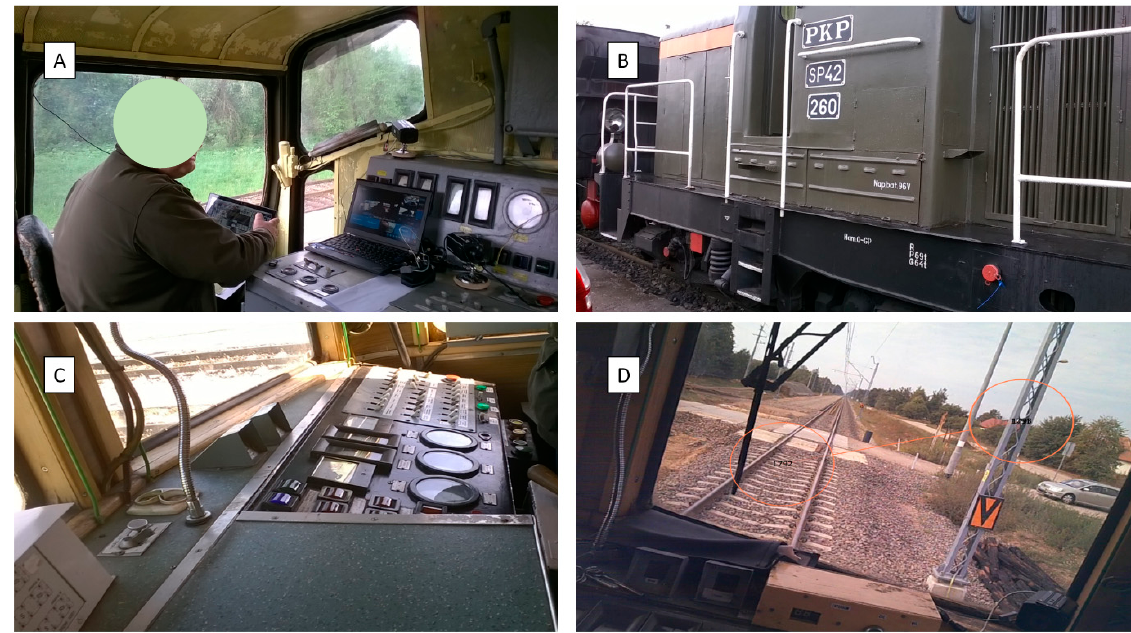
Figure 2. EN57 suburban multiple-unit set and SM42 locomotive used in the studies: ( A ) SM42 interior; ( B ) SM42 locomotive; ( C ) EN57 driver’s desk; ( D ) view from EN 57. Source: authors’ photographs.